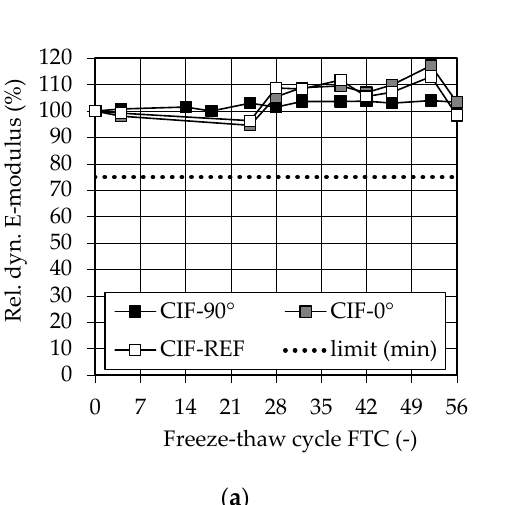
The measurement of the relative dynamic E-modulus, which is decisive for the CIF